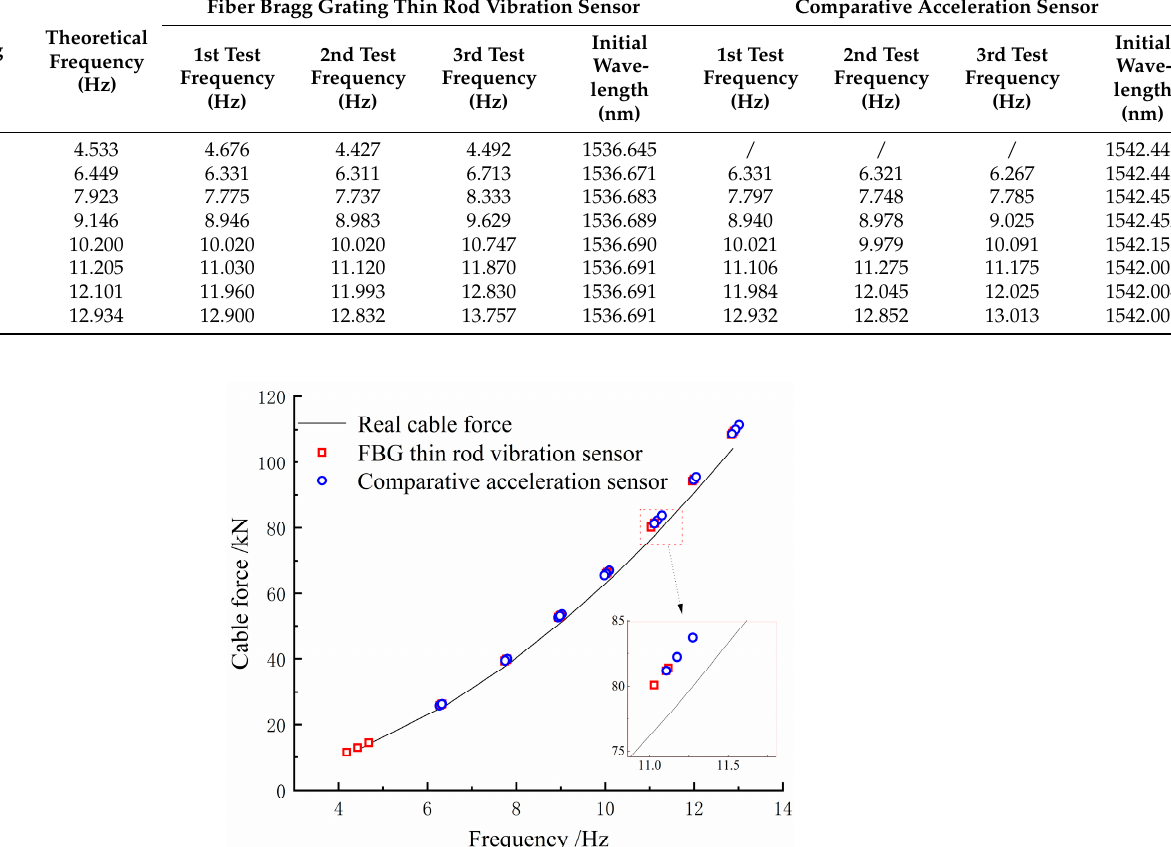
Figure 9. Comparison of cable force converted from fundamental frequency and actual value.